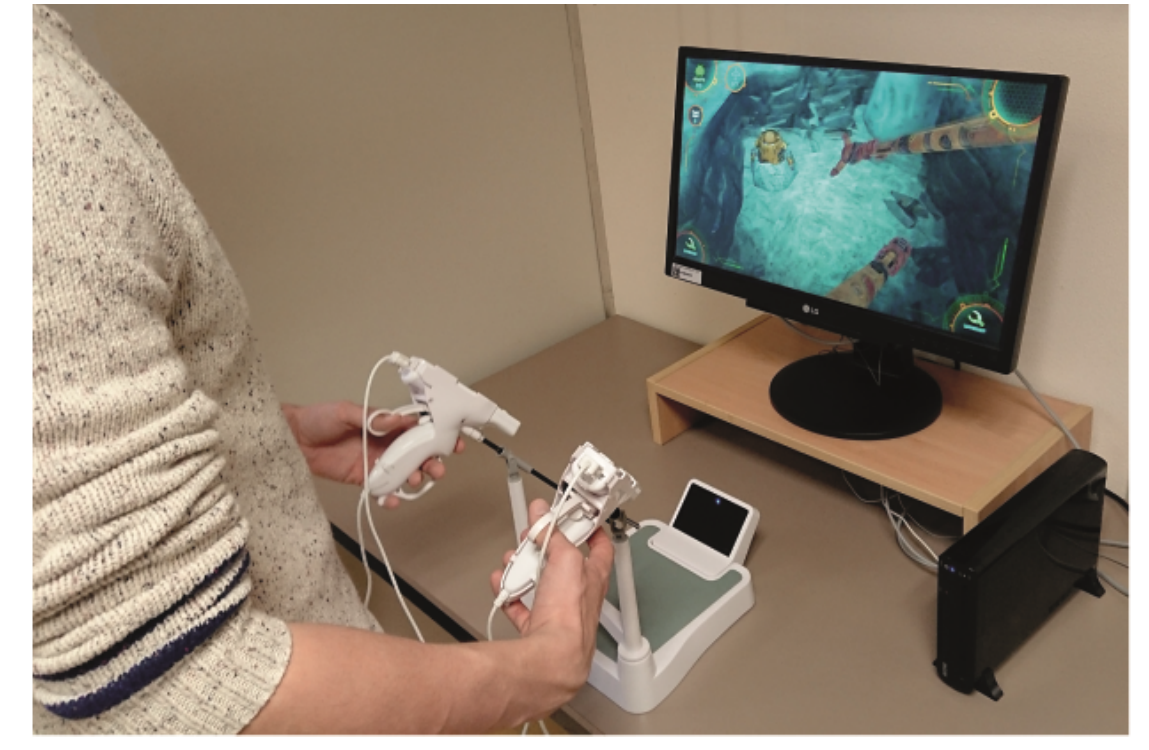
Figure 1. Laparoscopic interface of the serious game Underground